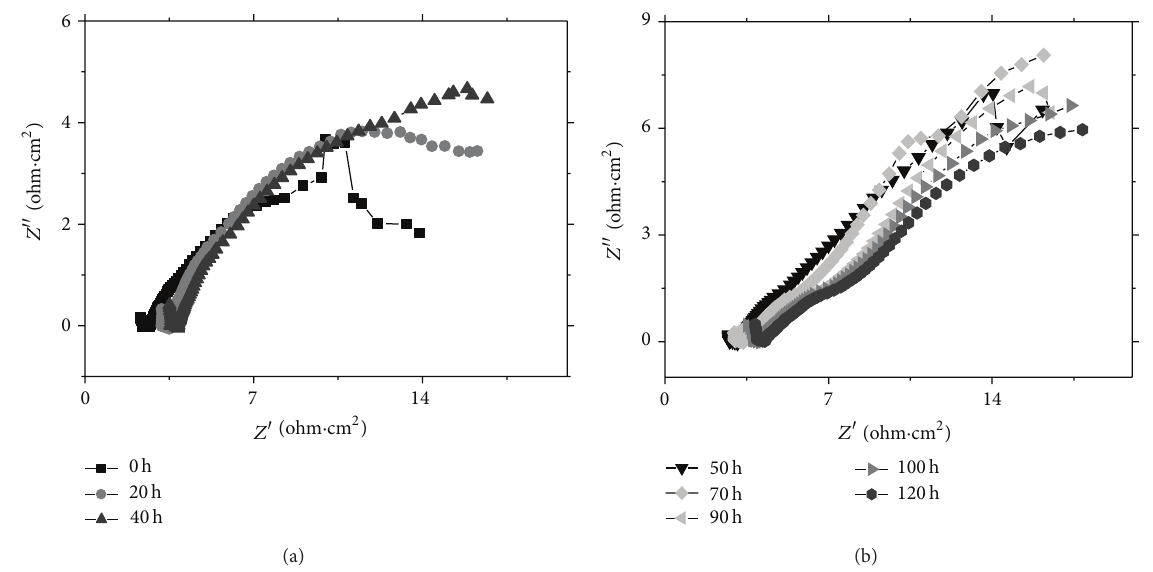
Figure 5: Nyquist plots for stainless steel 309 exposed to molten salts 50mol% V 2 O 5 -50 mol% Na 2 SO 4 at 700 ∘